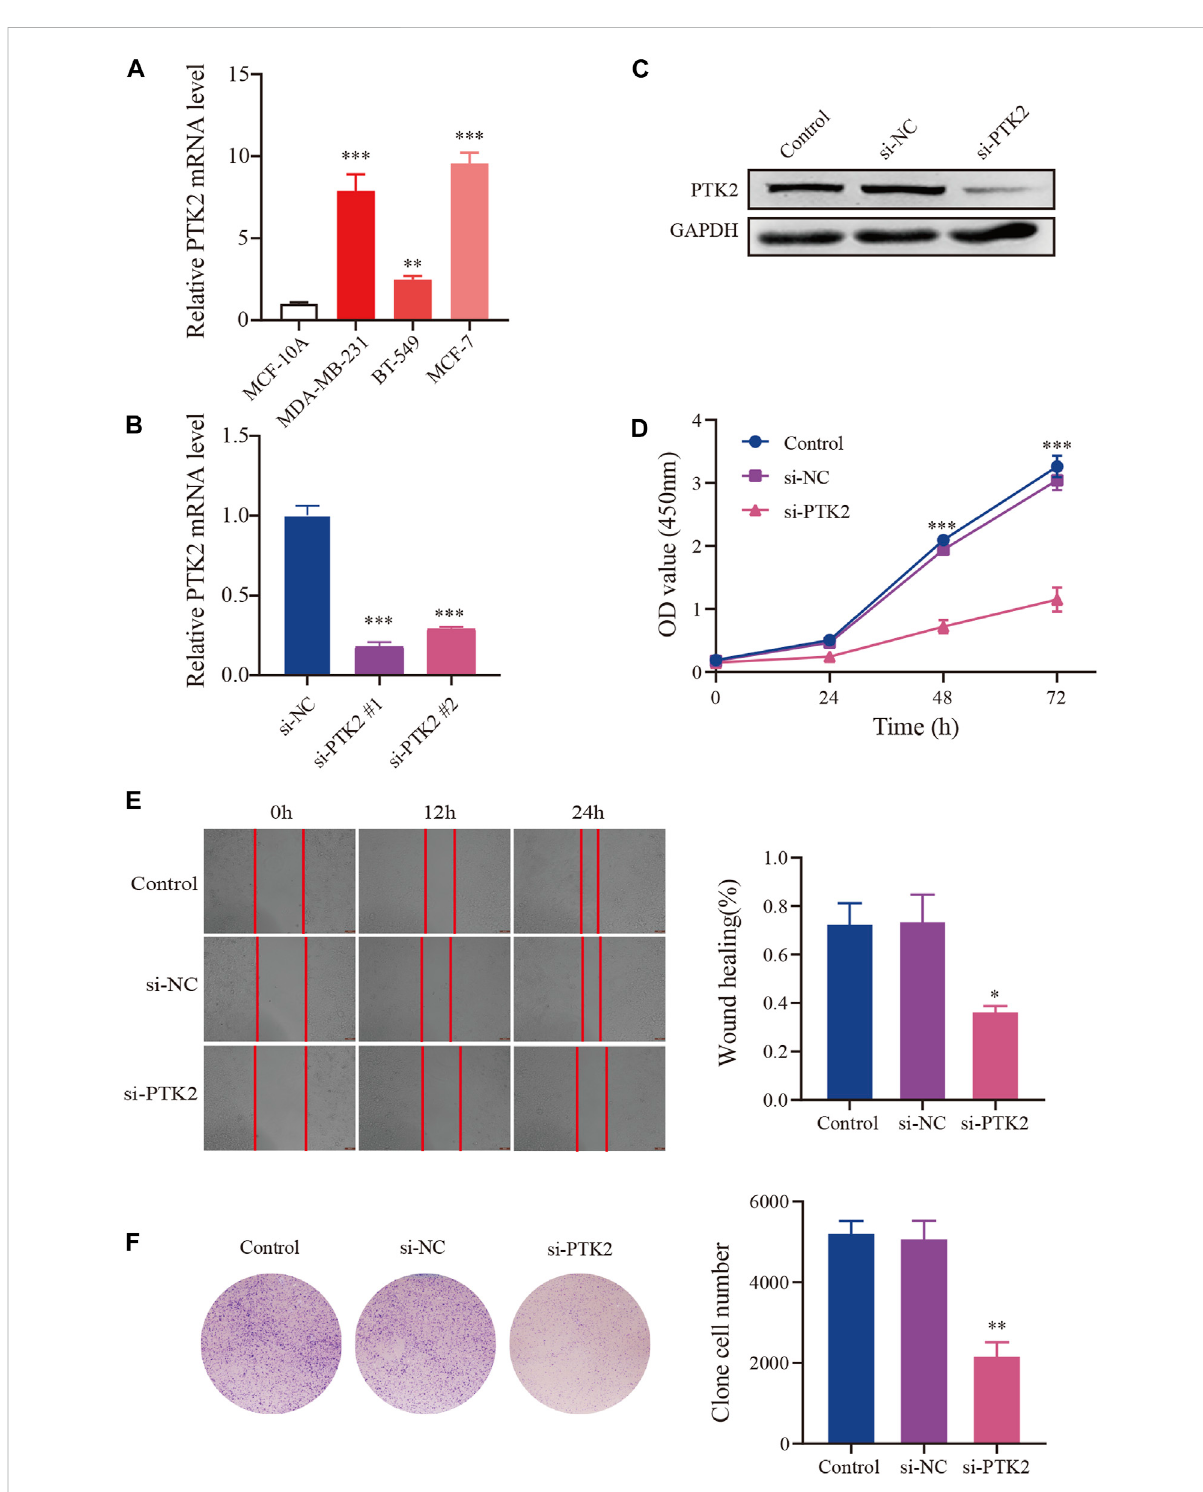
FIGURE 10 Knockdown of NR2F6 inhibits malignant phenotypes in MCF7 cells. (A) PTK2 mRNA expression level in breast cancer cell lines. (B) Knockdown ef fi cacy of PTK2 siRNAs in MCF7 cells detected by RT – qPCR. (C) PTK2 protein expression level of MCF7 cells in control, si-NC, and si-PTK2 groups. (D) CCK8 was performed to estimate the effects of PTK2 knockdown on MCF7 cell proliferation. (E) Colony forming ability of MCF7 cells transfected with si-PTK2. (F) Wound healing assay after transfection with PTK2 siRNA or control siRNA in MCF7 cells. Quantitative data are indicated as mean ± SEM ( n = 3). * p < 0.05, ** p < 0.01, and *** p < 0.001 vs. si-NC and control